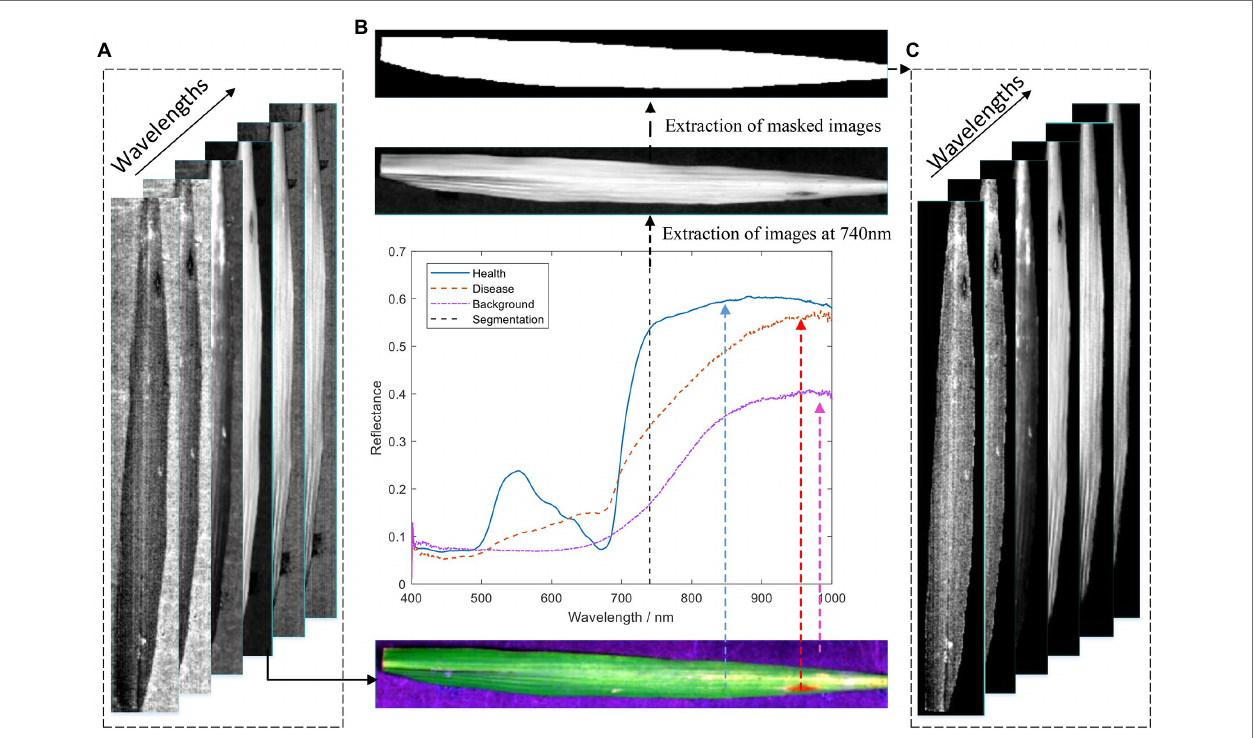
FIGURE 3 | Flow chart of hyperspectral image data extraction: (A) original hyperspectral image; (B) acquisition of mask image; and (C) hyperspectral image of a leaf with background